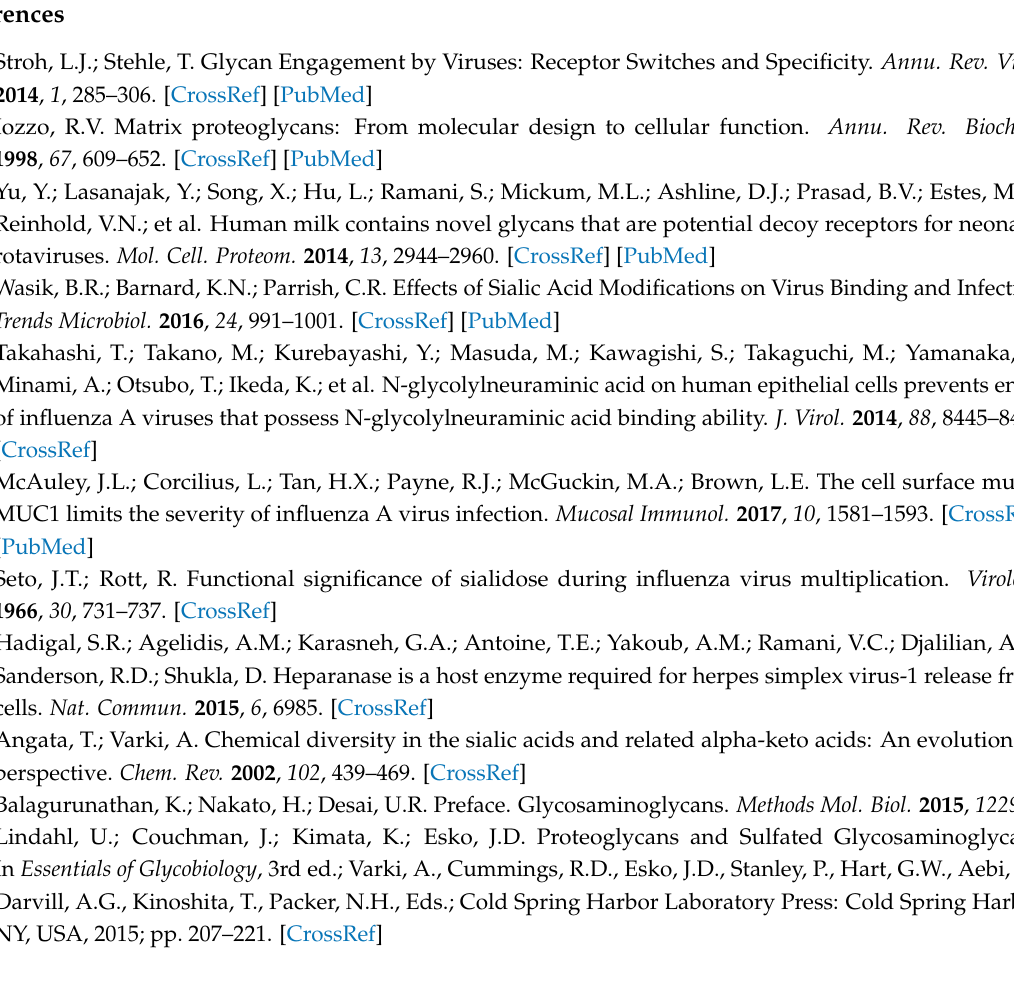
Table S1: probes investigated in a focused GAG microarray and Table S2: supplementary glycan microarray document based on MIRAGE